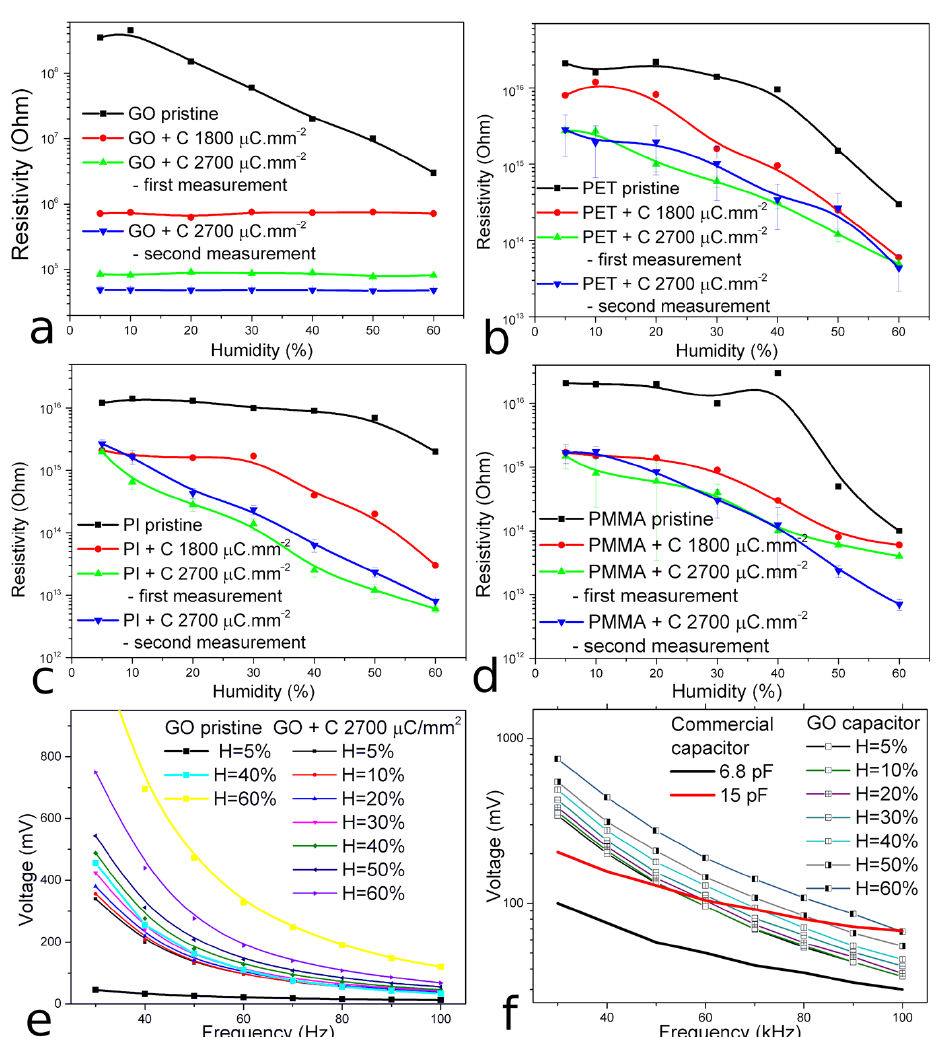
Figure 8. The electric resistivity and frequency–voltage characteristics of prepared micro-structures depending on the relative humidity: ( a ) The sheet resistivity of GO microstructures, ( b ) the sheet resistivity of PET microstructures, ( c ) the sheet resistivity of PI microstructures, ( d ) the sheet resistivity of PMMA microstructures, ( e ) the voltage–frequency characteristic of the structure prepared on the GO surface with a fluence 5.625 × 10 14 cm − 2 , ( f ) the voltage–frequency characteristic of the structure prepared on the GO surface with a fluence of 5.625 × 10 14 cm − 2 in logarithmic scale and compared with commercial ceramic capacitors.